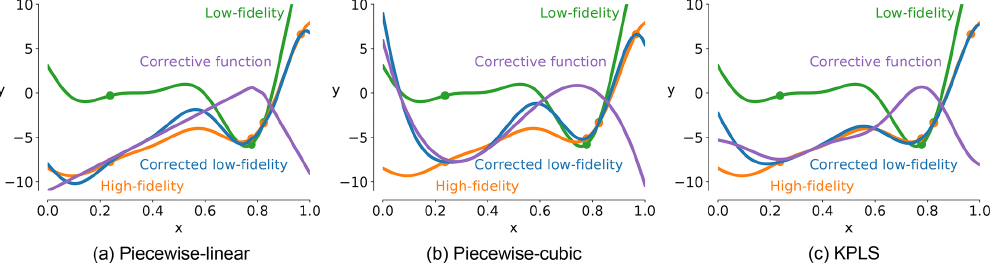
Figure 4. Corrective function formulation with piecewise linear reasonably approximating the higher-fidelity model (a) , piecewise cubic in- troducing unwanted oscillations in the approximation (b) , and KPLS-based corrective function matching the high-fidelity most accurately (c)